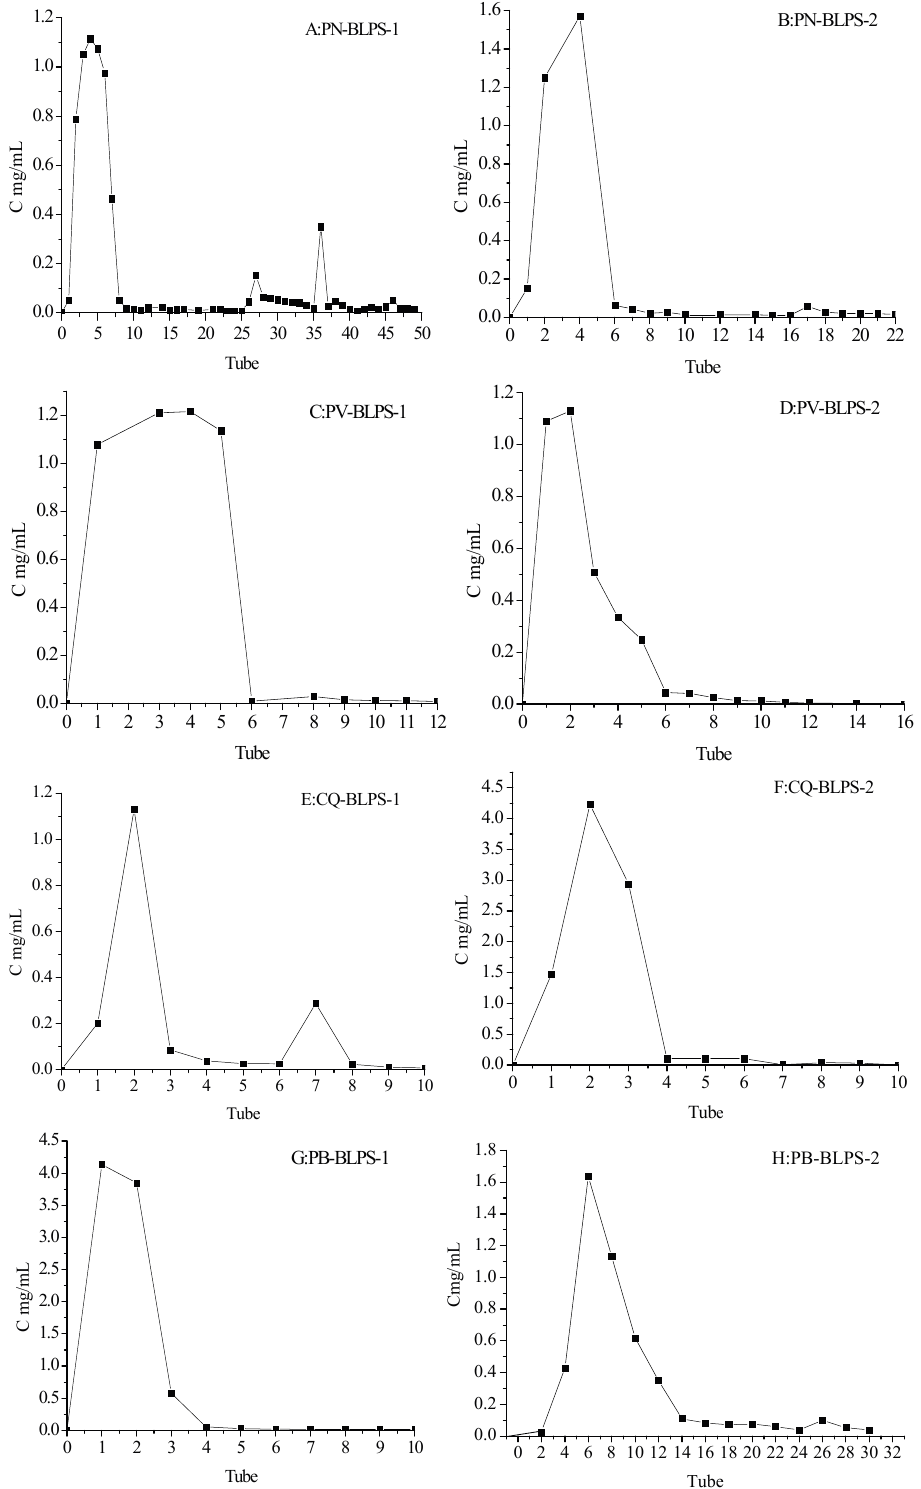
Figure 3. Separation of DPS from four varieties of bamboo leaves. ( A , B ) from Phyllostachys nigra (PN); ( C , D ) from Phyllostachys vivax (PV); ( E , F ) from Chimonobambusa quadrangularis (Fenzi) Makino (CQ), ( G , H ) from Phyllostachys bambusoides (PB) by a DEAE-52 cellulose